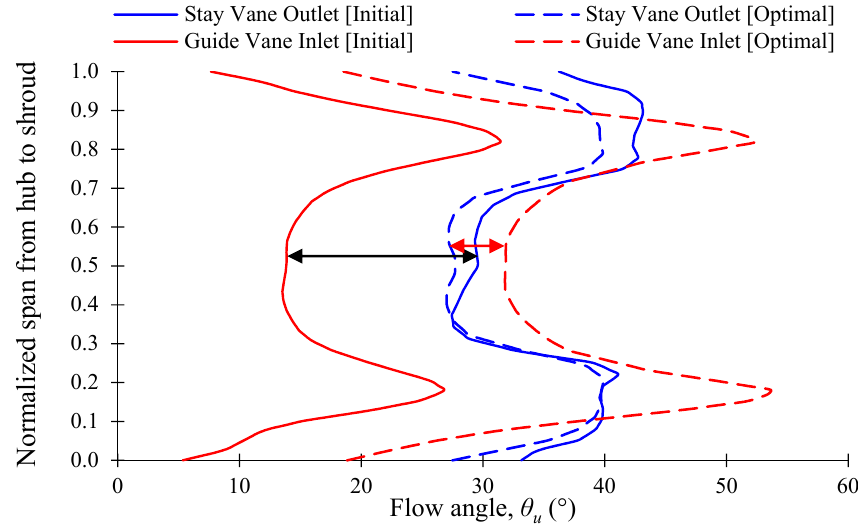
Figure 16. Comparison of flow angle in the ISV and OSV at the design point.